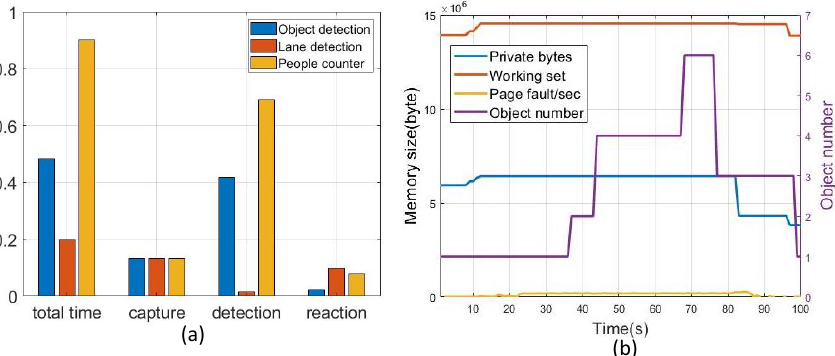
Figure 12. ( a ) Time measurement of process, ( b ) Memory usage of the object detection algorithm.